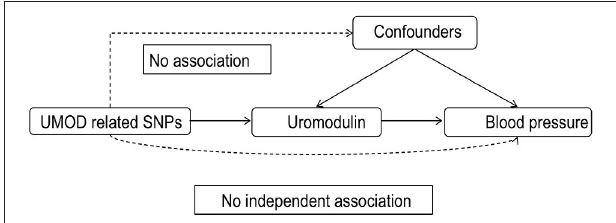
FIGURE 1 | Directed acyclic graph composed of the genetic instrument (UMOD-related SNPs), exposure (UMOD), and outcome (blood pressure). SNPs, Single nucleotide polymorphisms; UMOD,